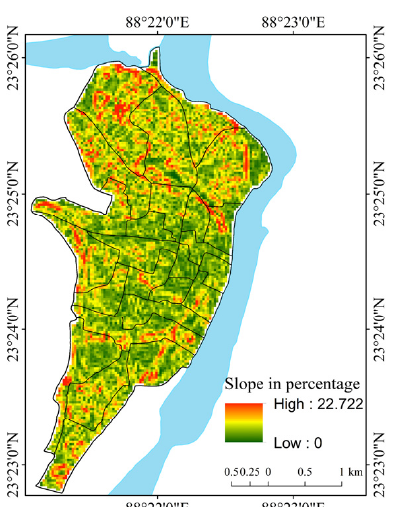
Figure 30. Slope (2015).